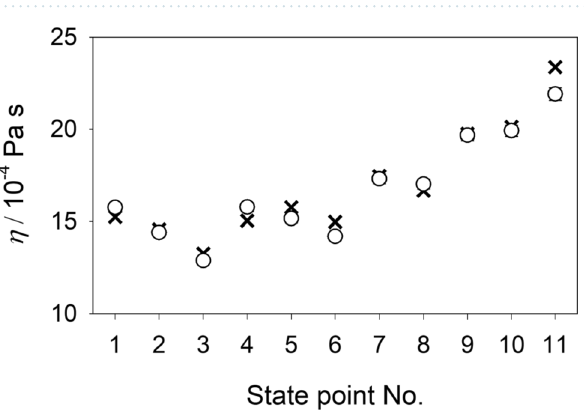
Figure 10. Shear viscosity of the six binary subsystems at 298.15 K and 0.1 MPa. Present simulation results (circles) are compared with experimental literature data 52–55 (crosses).